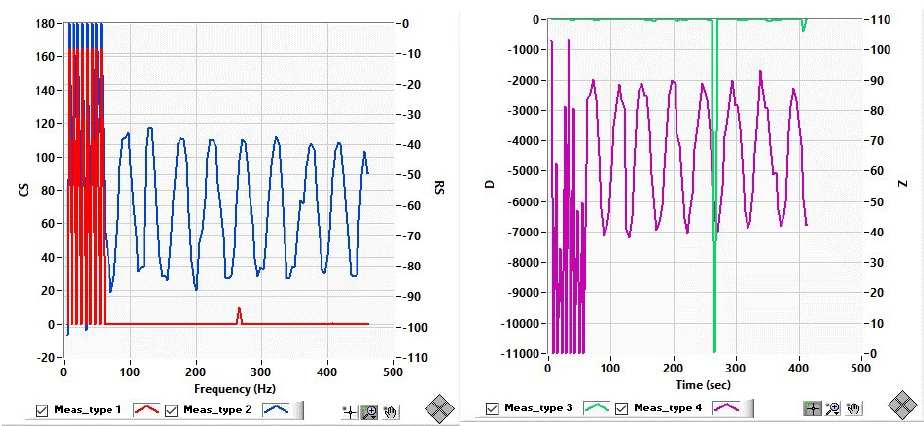
Figure 7. A plot of capacitance against ESR and dissipation factor against